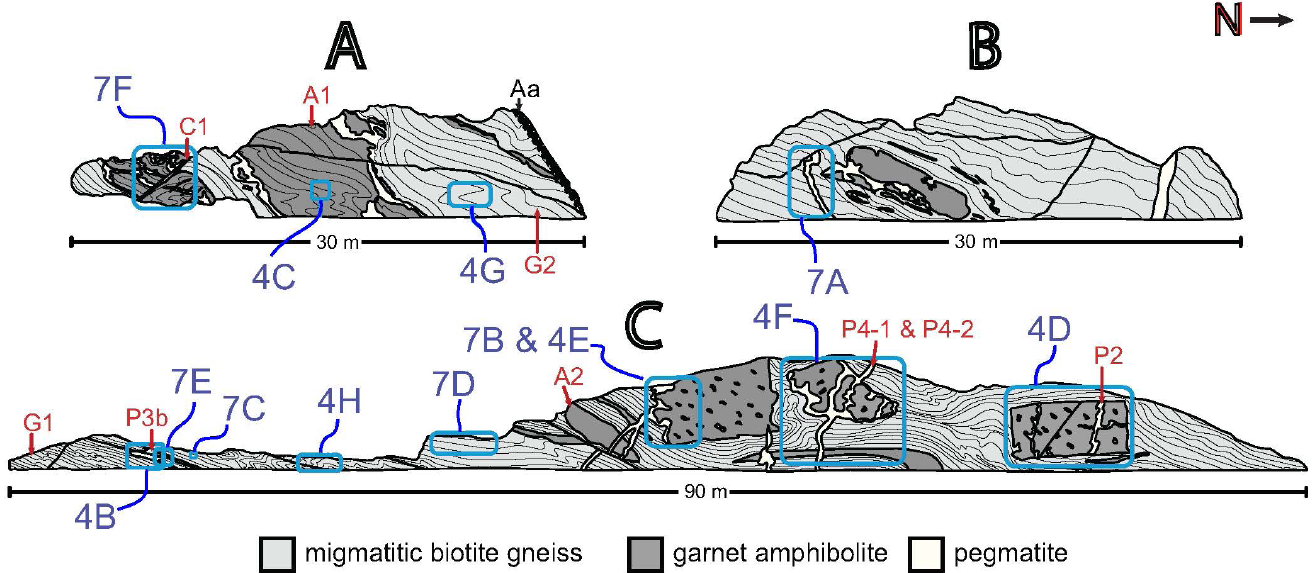
Figure 3. Detailed map of the complete shear zone at Halden, with sample sites (in red) and location of pictures shown in figures 4 and 7 (in